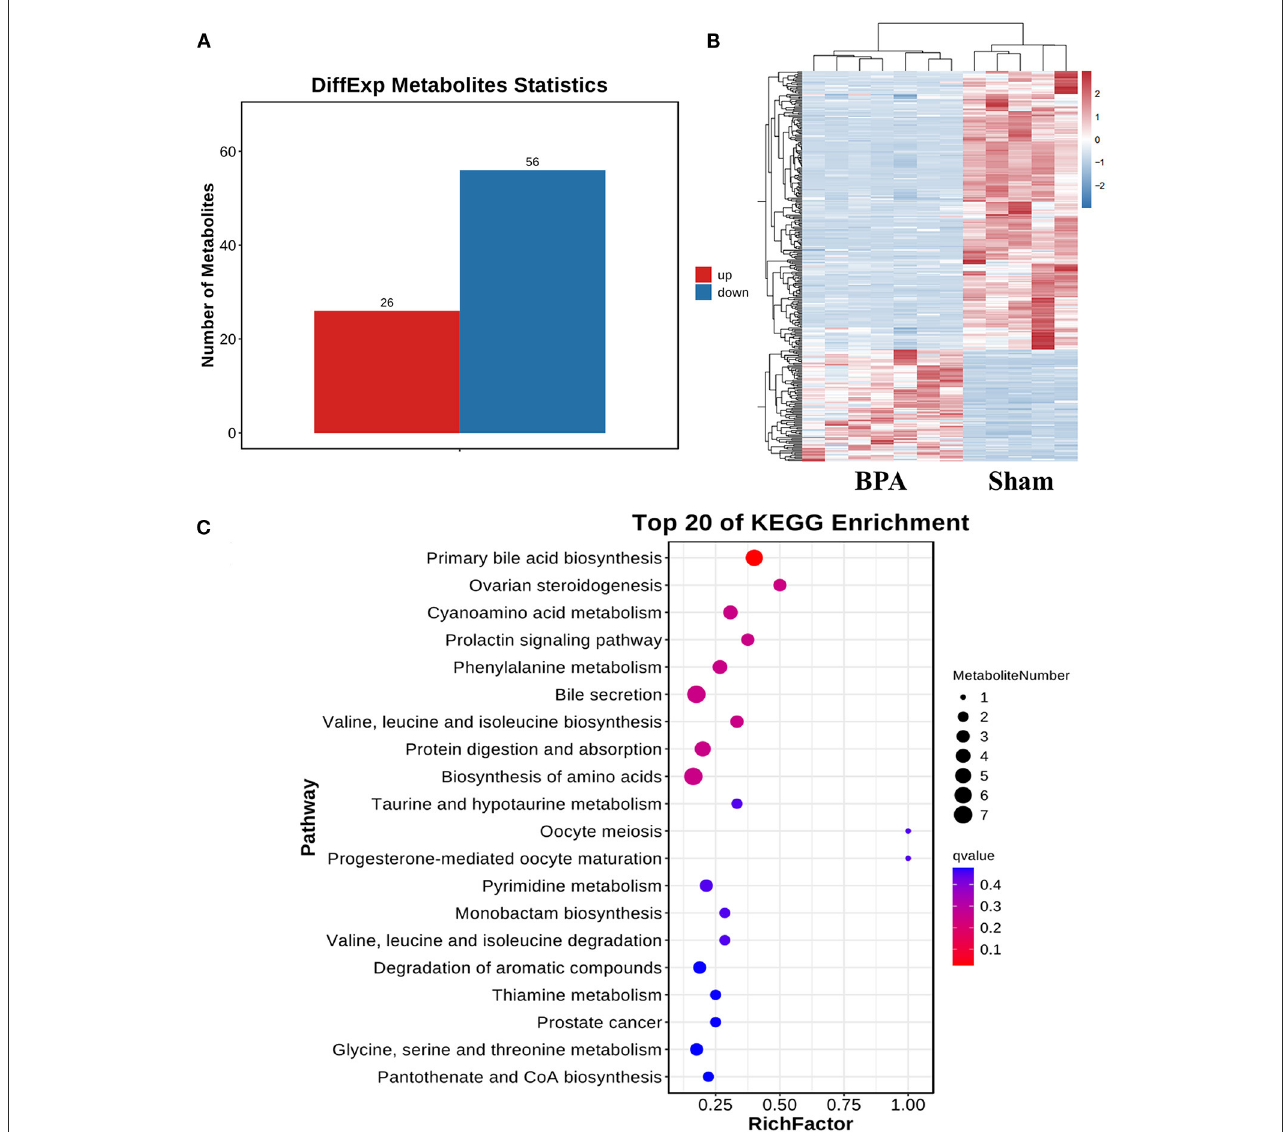
FIGURE4 Gut bacteria metabolites sequencing analysis of sham and BPA mice. (A) Differentially expressed metabolites in BPA groups compared to the sham group. (B) Cluster heat map of the differentially expressed metabolites between the two groups. (C) KEGG functional enrichment analysis of the differentially expressed metabolites.